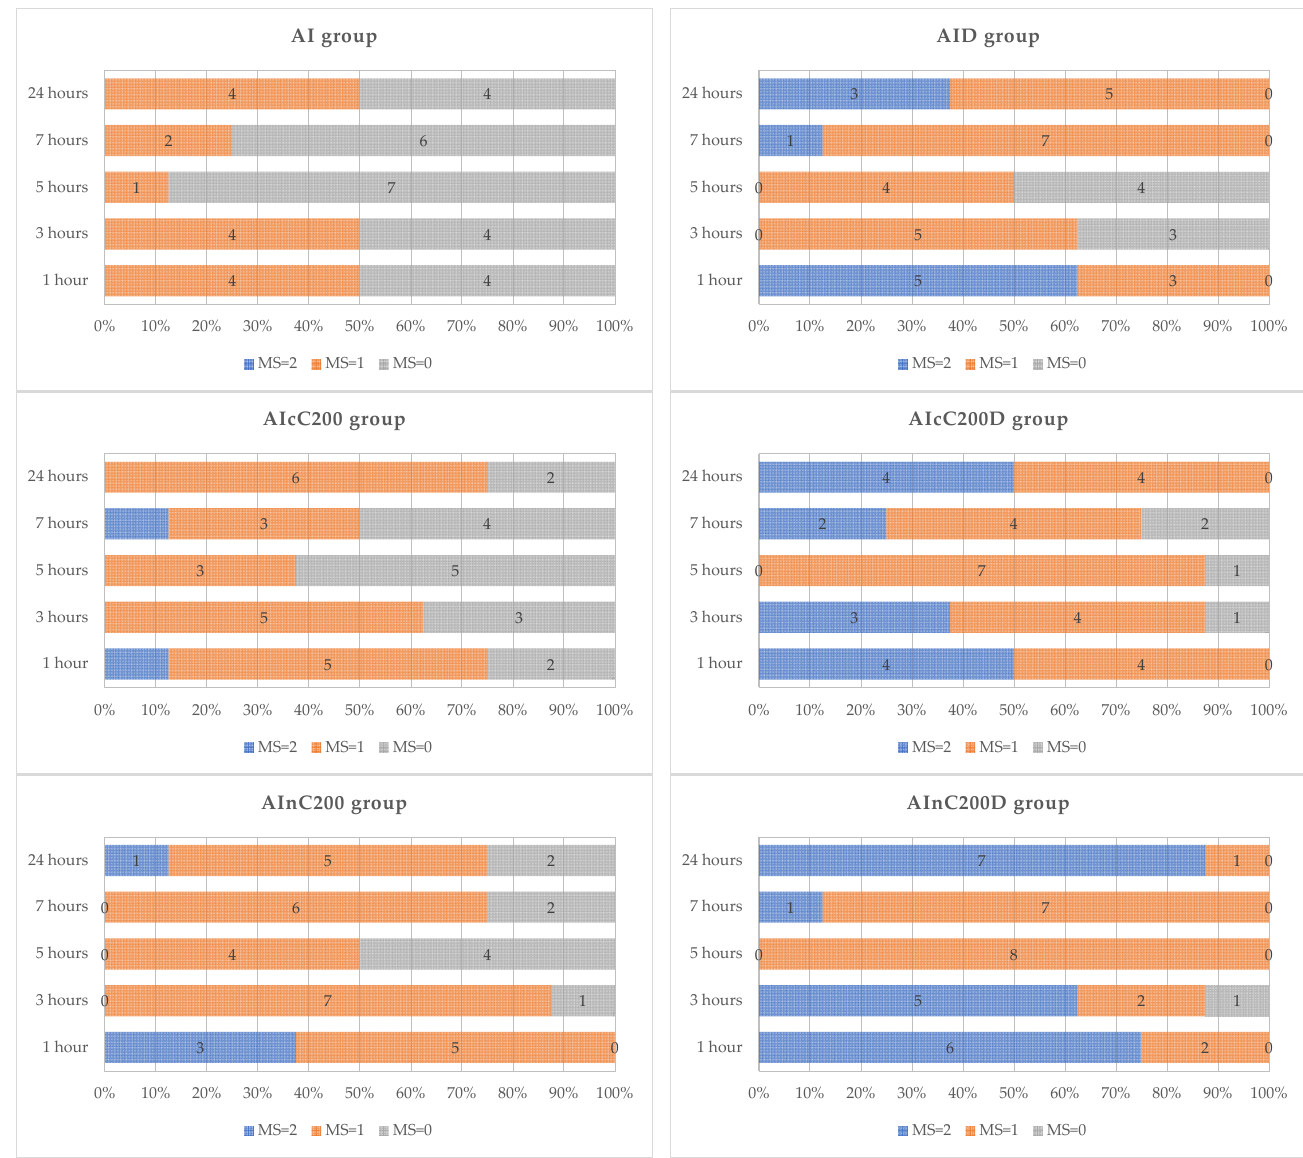
Figure 1. Effects of diclofenac sodium (D), conventional curcumin (cC), and curcumin nanoparticles (nC) on motility score (MS). Interpretation: MS = 2 indicates no motility problems; MS = 1 indicates some motility problems (walk with difficulty but with the toe of the inflamed paw touching the floor), and MS = 0 indicates motility problems (walk with difficulties and avoided touching the right hind paw to the floor). C—control (n=8); AI—Acute inflammation (n=8); D—Diclofenac sodium (n=8); cC—conventional curcumin solution (200 mg/kg b.w.; n=8); nC—curcumin nanoparticles solution (200 mg/kg b.w.; n=8).